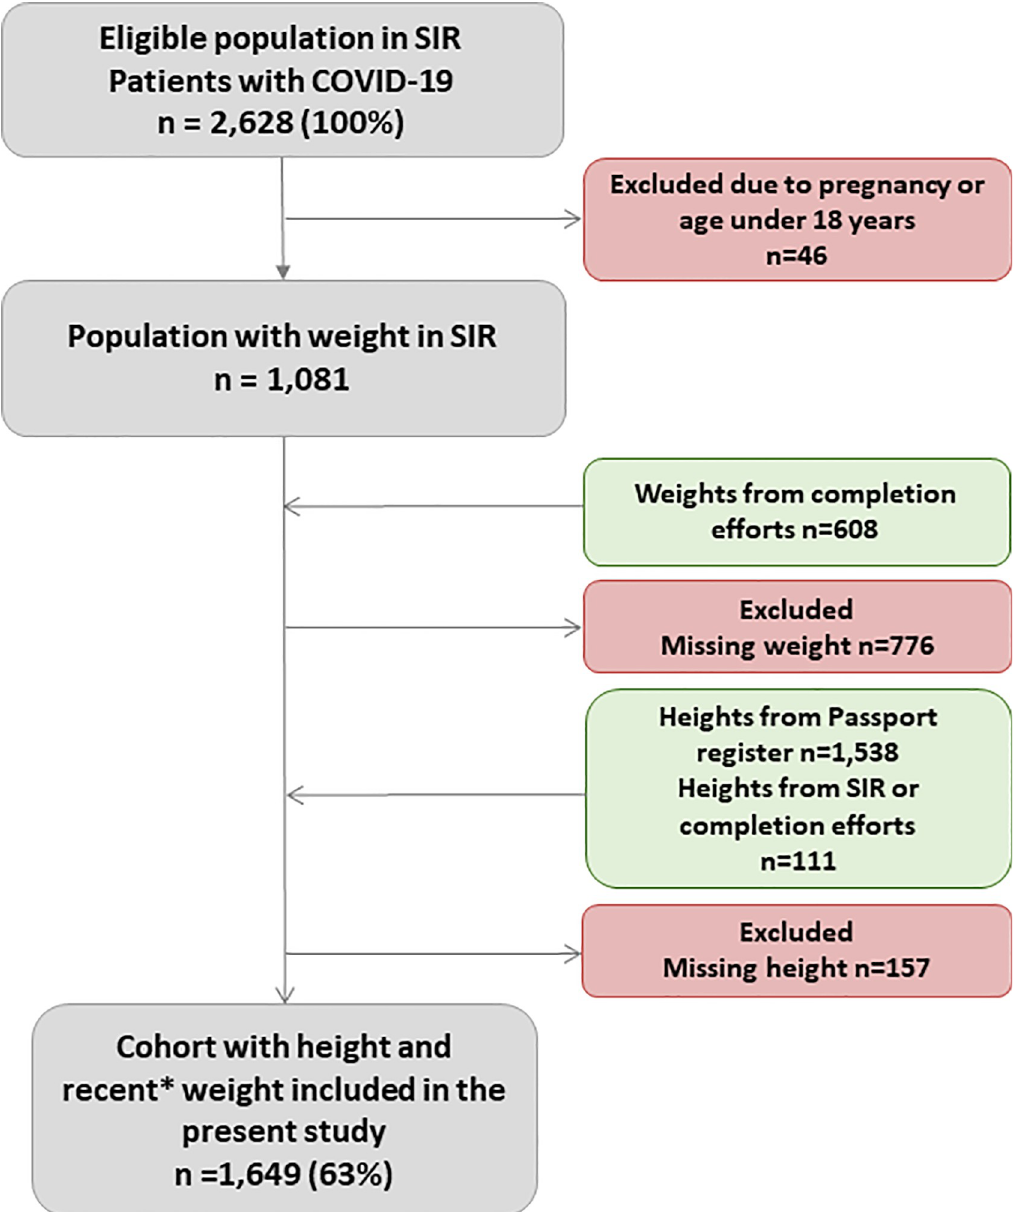
Fig 1. Flow chart of inclusion in the present study cohort. SIR = Swedish Intensive Care